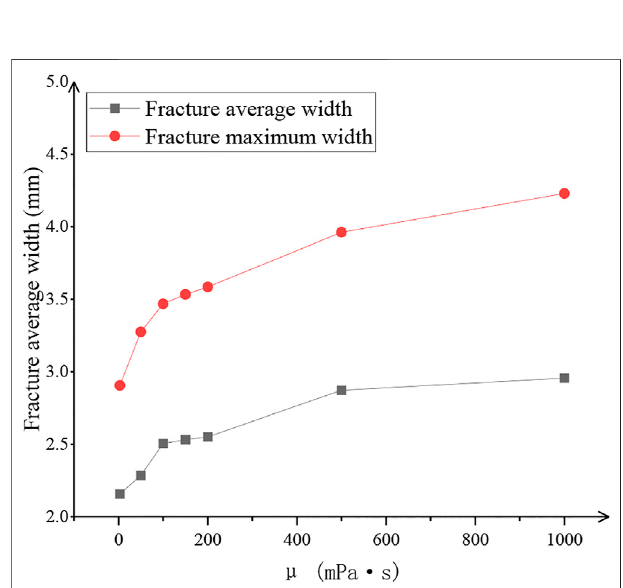
FIGURE 8 | Fracture width and propagation path in hydraulic fracturing: (A) Case 1.1, (B) Case 1.2, (C) Case 1.3, (D) Case 1.4, (E) Case 1.5, and (F) Case 1.6.